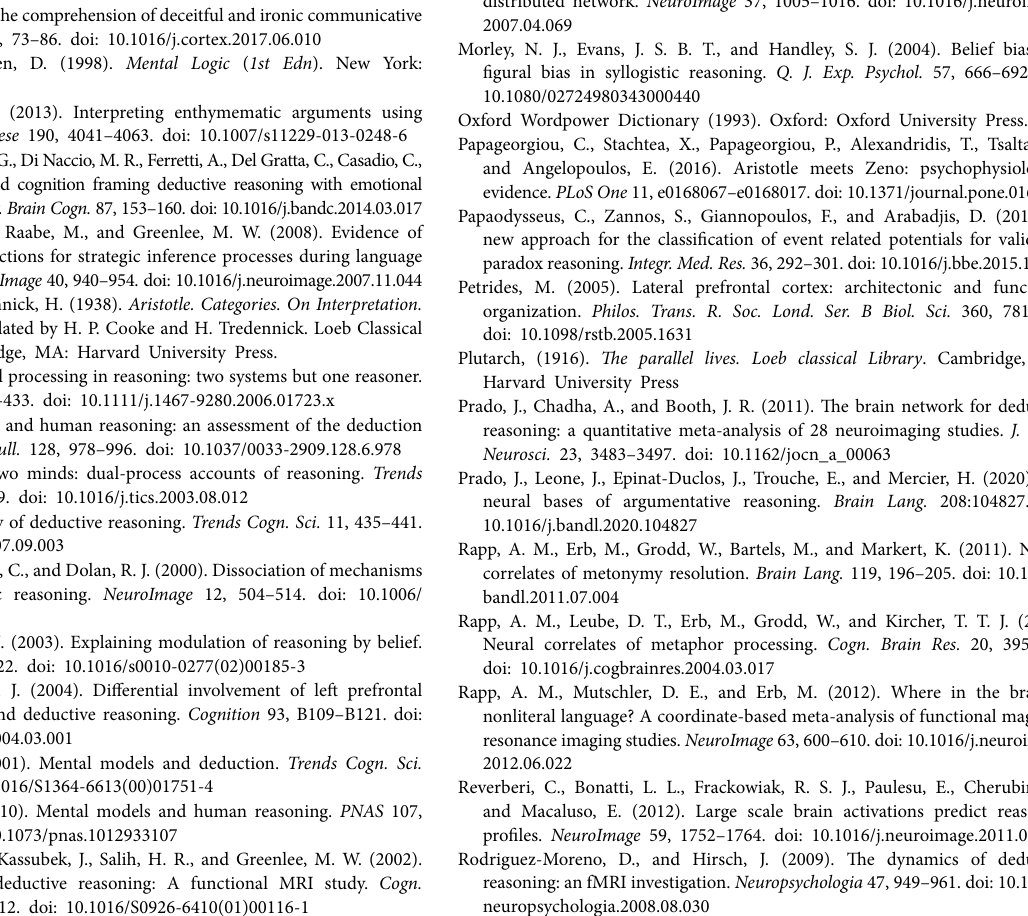
figural bias in syllogistic reasoning. Q. J. Exp. Psychol. 57, 666–692. doi: